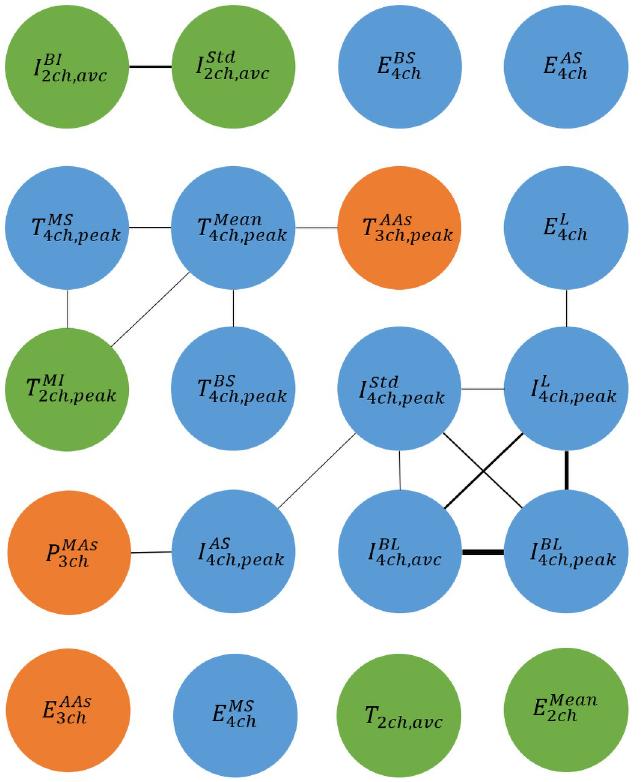
Fig 5. Correlation between the 20 most important features (blue: 4ch, orange: 3ch, and green: 2ch). The thickness of the line represents the importance of the correlation between the two features. Only correlation coefficients higher than 0.5 are displayed.